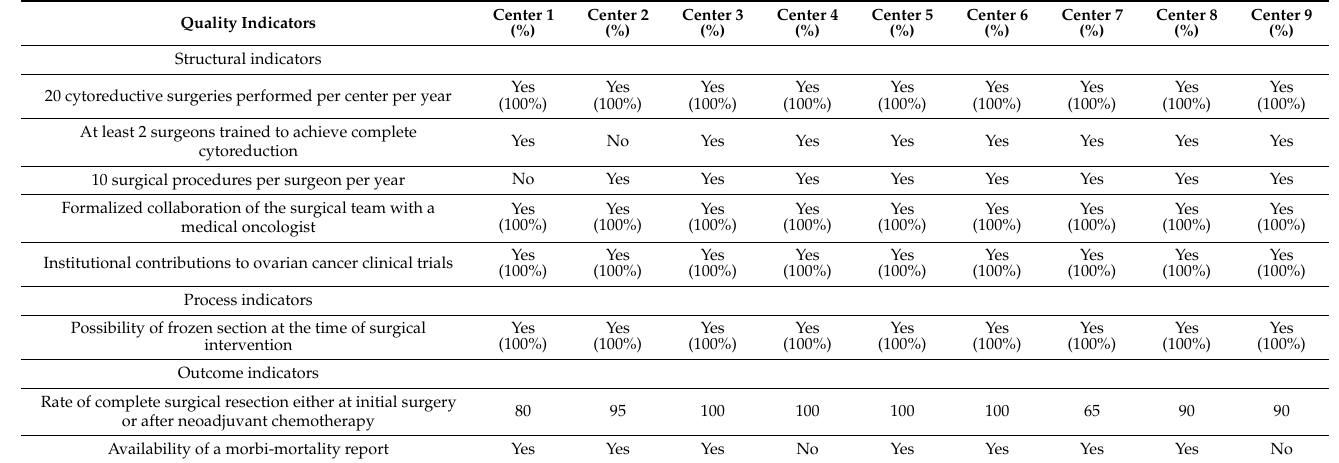
Table 2. Expert validation of quality indicators.